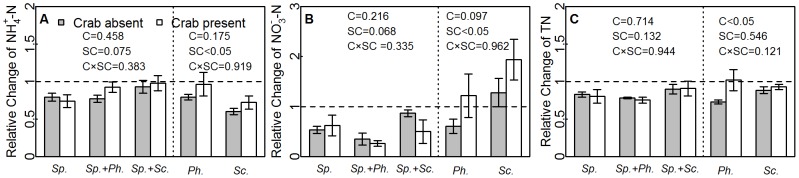
The relative change of soil nitrogen.The effects of crab and species combinations on the relative changes of NH4
+-N (mean ± SE, A), NO3
− -N (mean ± SE, B), and TN (mean ± SE, C) were tested using two-way ANOVA. The P-values of the effects of crabs and species combinations on relative change of nitrogen are given, where “C” stands for crab treatment and “SC” for species combination. The vertical dash line divides the species combinations into Spartina-present plots and Spartina-absent plots, and the horizontal dash line at 1 distinguishes nitrogen increase from decrease.